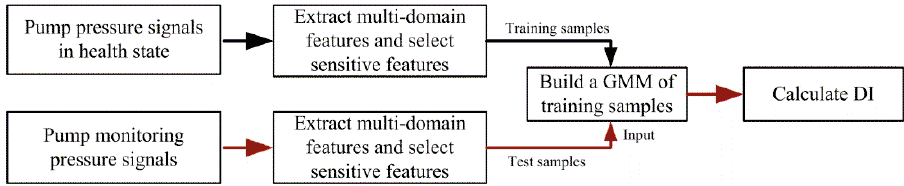
Figure 2. Flowchart of the acquisition process of the DI.